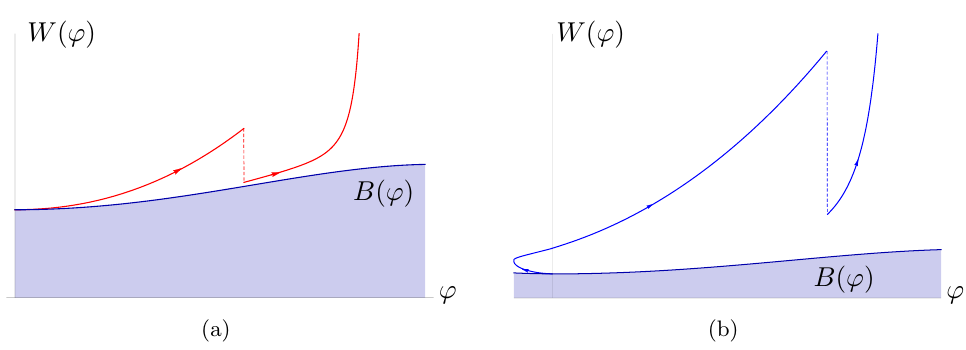
Figure 7 . Two solutions for W ( ’ ) with the same value of R but di(cid:11)erent sign of ’ (cid:0) . The results were obtained for bulk potential (3.1), brane quantities (3.2) and parameter values (3.3). The jump in W is the discontinuity across the brane. In (cid:12)gure (a) we plot a solution with ’ (cid:0) > 0, while in (b) a solution with ’ (cid:0) < 0 is shown. Note that the solution with ’ (cid:0) < 0 exhibits a bounce, i.e. a reversal of direction in ’